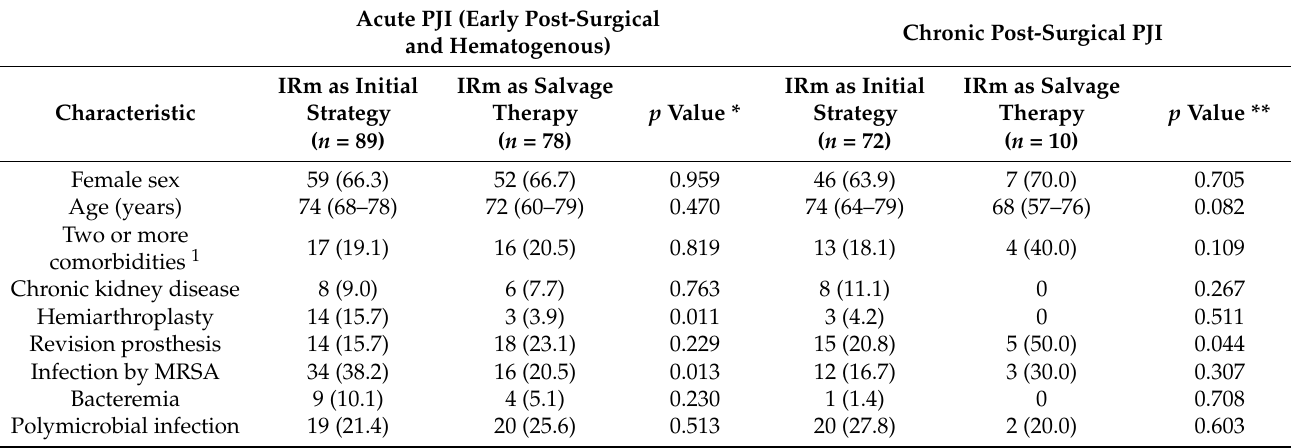
Figure 2. Kaplan–Meier curves of mortality of cases with acute prosthetic joint infection by Staphylococcus aureus managed initially with implant removal. ( A ) Patients with and without two or more comorbidities. ( B ) Patients with and without hemiarthroplasty. ( C ) Patients with infection by methicillin-resistant (MRSA) or methicillin-susceptible S. aureus (MSSA). ( D ) Patients with and without bacteremia. Table 2. Characteristics and outcome of the subcohort of cases of prosthetic joint infection by Staphylococcus aureus managed with implant removal ( n = 249), according to their type of